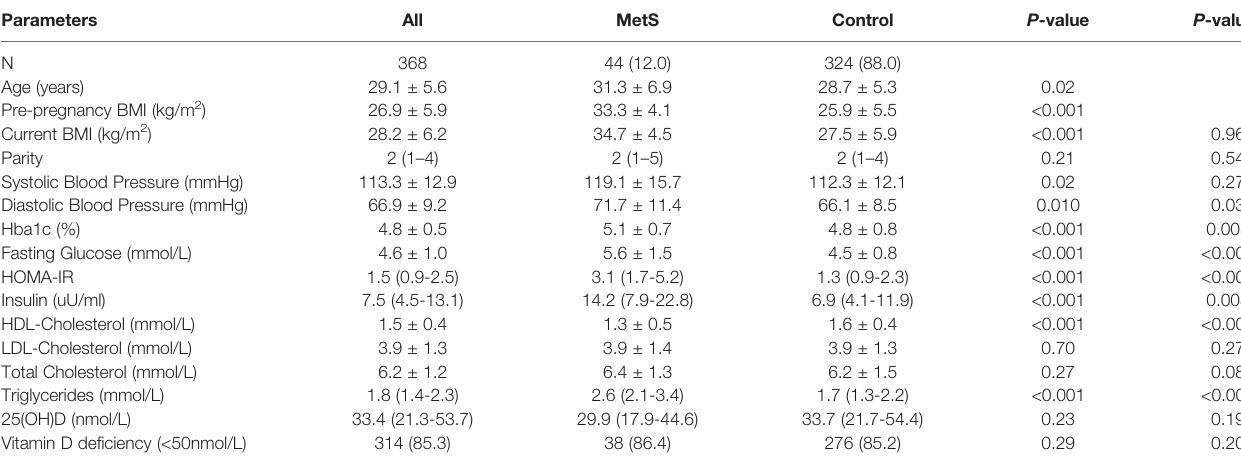
TABLE 1 | Demographic and biochemical characteristics of MetS vs. control groups. Parameters